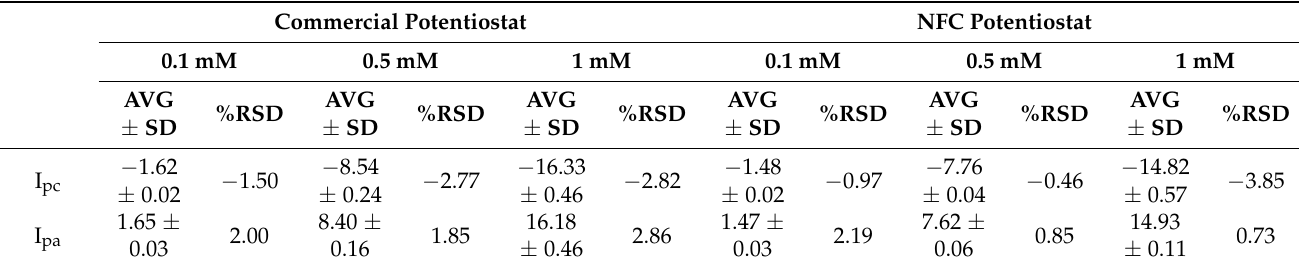
Figure 3. Cyclic voltammograms of ( a ) 0.1 mM, ( b ) 0.5 mM and ( c ) 1 mM potassium ferricyanide containing 0.1 M KCl using the NFC potentiostat (red) and a commercial potentiostat, CHI 611E, (black) sweeping the potential between − 300 mV and 600 mV, at a scan rate of 100 mV/s. Table 1. The average (AVG), standard deviation (SD) and relative standard deviation (RSD) of cathodic and anodic peak currents using the commercial potentiostat and the NFC potentiostat.